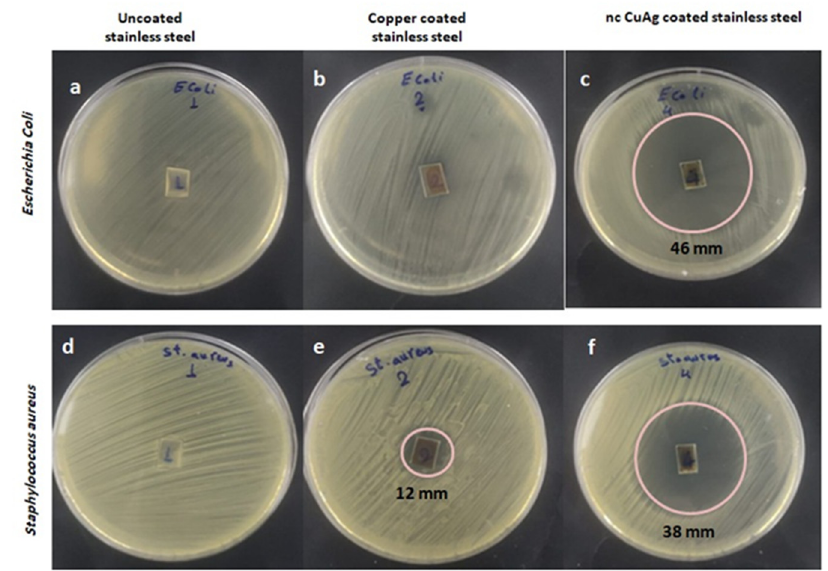
Figure 14. Antibacterial effect of uncoated stainless steel ( a , d ), copper-coated stainless steel ( b , e ), and the ncCuAg-coated stainless steel ( c , f ) against Escherichia coli ( a – c ) and Staphylococcus aureus ( d – f